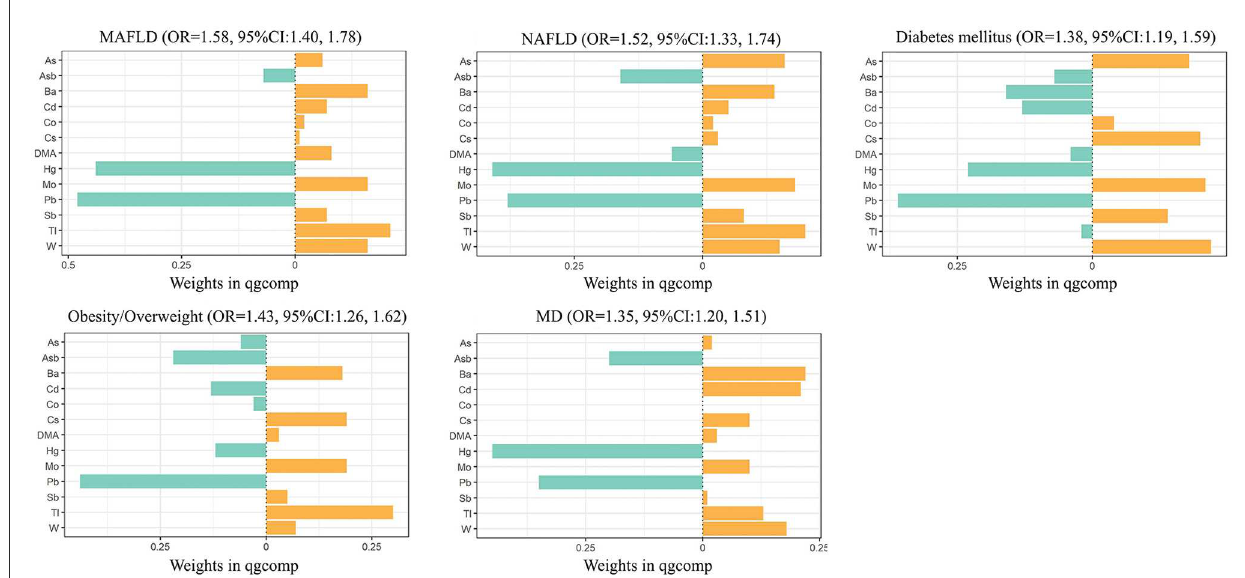
FIGURE1 Combined association (95%CI) and qgcomp weights of metal mixture with MAFLD, NAFLD, and components of MAFLD by QGC models. Models were adjusted for age, gender, race, research cycle, education level, smoking status, poverty income ratio, and physical activity. Qgcomp, quantile g-computation; MAFLD, metabolic associated fatty liver disease; NAFLD, non-alcoholic fatty liver disease; MD, metabolic